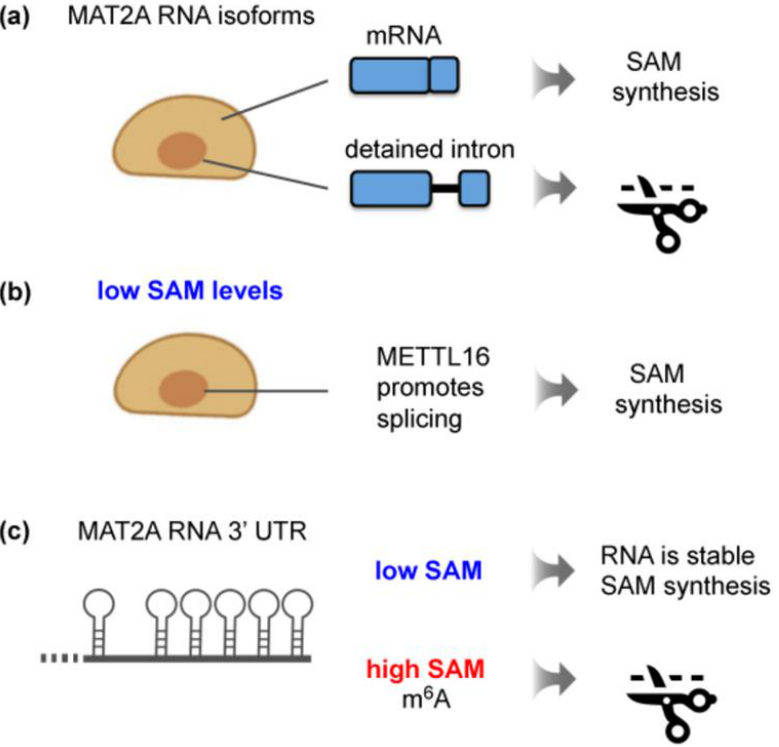
Figure 3. Regulation of mammalian MAT2A expression by METTL16 in response to intracellular SAM levels. ( a ) Mammalian MAT2A has two transcript isoforms: a cytoplasmic mRNA and a nuclear, unproductive isoform with a detained last intron. ( b ) Stable METTL16 binding to the 3′UTR of MAT2A induces full splicing of MAT2A pre-mRNA, leading to increased SAM synthesis. This effect is independent of m 6 A deposition by METTL16. ( c ) The 3′UTR of MAT2A contains six hairpins. Their m 6 A methylation by METTL16 results in SAM-responsive RNA degradation of MAT2A mRNA. Given that the 3′UTR hairpins of MAT2A mRNA are found exclusively in vertebrates [93], a different mechanism must operate in lower eukaryotes.